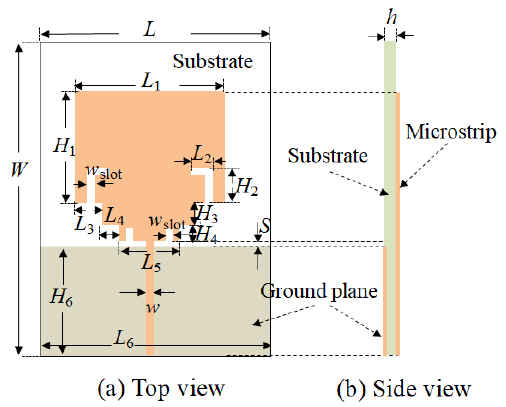
Figure 1. Structure of the proposed ultra-wideband (UWB) antenna. ( a ) Top view; ( b ) Side view.